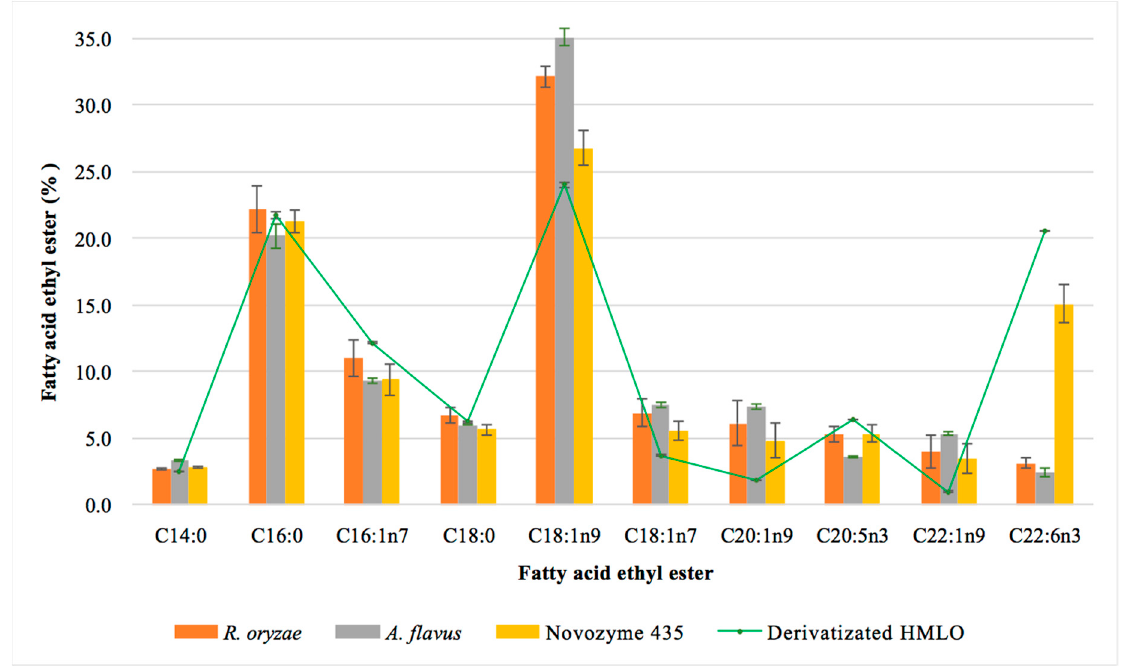
Figure 6. Effect of the biocatalyst on the percentage of the main ethyl esters obtained in a 72 h two-step reaction. Hydrolyzed monkfish liver oil (HMLO) corresponds to the total content of the corresponding ethyl ester in the hydrolyzed monkfish liver oil.